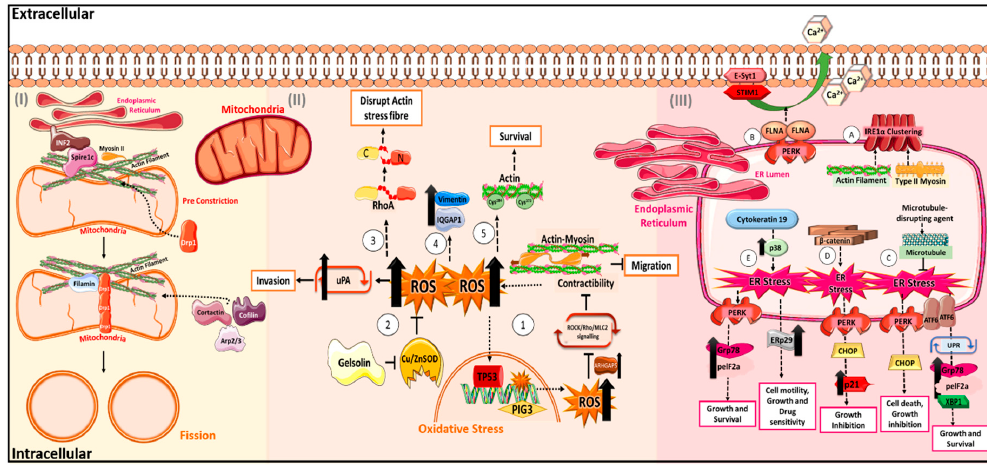
Figure 2. Overview of how some cytoskeletal molecules function in cellular stress. ( I ) Cytoskeletal proteins facilitate the Drp1-mediated mitochondria fission through the recruitment of Drp1 to the contact sites and subsequent fission with the aid of translocated cofilin, Arp2/3 and cortactin to the mitochondria. ( II ) Cytoskeleton and its associated proteins can function in oxidative stress. Oxidative stress can be regulated by actin and its associated proteins such as myosin and gelsolin to affect migration and invasion (1,2). On the other hand, oxidative stress acts to promote survival, actin stress fibre disruption and changes in gene expression (3,4,5). ( III ) Cytoskeletal molecules are important in the colocalization and function of important ER sensors in the presence of ER stress (A,B). In addition, other cytoskeletal molecules such as microtubules and β -catenin can activate downstream ER response pathways to promote cell death, growth inhibition and drug resistance. Cytokeratin 19 can also promote ER stress and upregulation of ER proteins to induce changes in cellular behaviour (C,D,E). Arp, Actin related protein; ATF, Activating transcription factor; Bip, Binding immunoglobulin protein; Ca2+, Calcium ion; CHOP, C/EBP homologous protein; Cu/ZnSOD, Copper- and zinc-containing superoxide dismutase; Drp, Dynamin-related protein; eIF2, Eukaryotic Initiation Factor 2; ER, Endoplasmic reticulum; ERp, Endoplasmic reticulum protein; E-Sty1, extended synaptotagmin-1; FLNA, Filamin A; GRP, Glucose-Regulated Protein; IQGAP1, Ras GTPase-activating-like protein IQGAP1; INF, Inverted Formin; IRE, Inositol-requiring enzyme; MLC2, Myosin light chain 2; PERK, Protein kinase RNA-like endoplasmic reticulum kinase ;PIG, p53- inducible gene ; ROS, Reactive oxygen species; ROCK, Rho-associated protein kinase; Rho, Ras Homolog; RhoA, Ras Homolog, Ras homolog family member A; SPIRE1, Protein spire homolog 1; STIM1, stromal interaction molecule 1; Tm, tropomyosin; TP53, Tumour protein p53; UPR, Unfolded protein response; XBP, X-box binding protein.